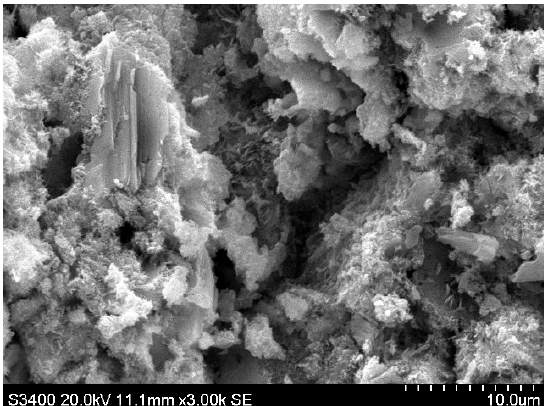
Figure 13. SEM image of OPM specimen. Materials 2018 , 11 , x FOR PEER REVIEW